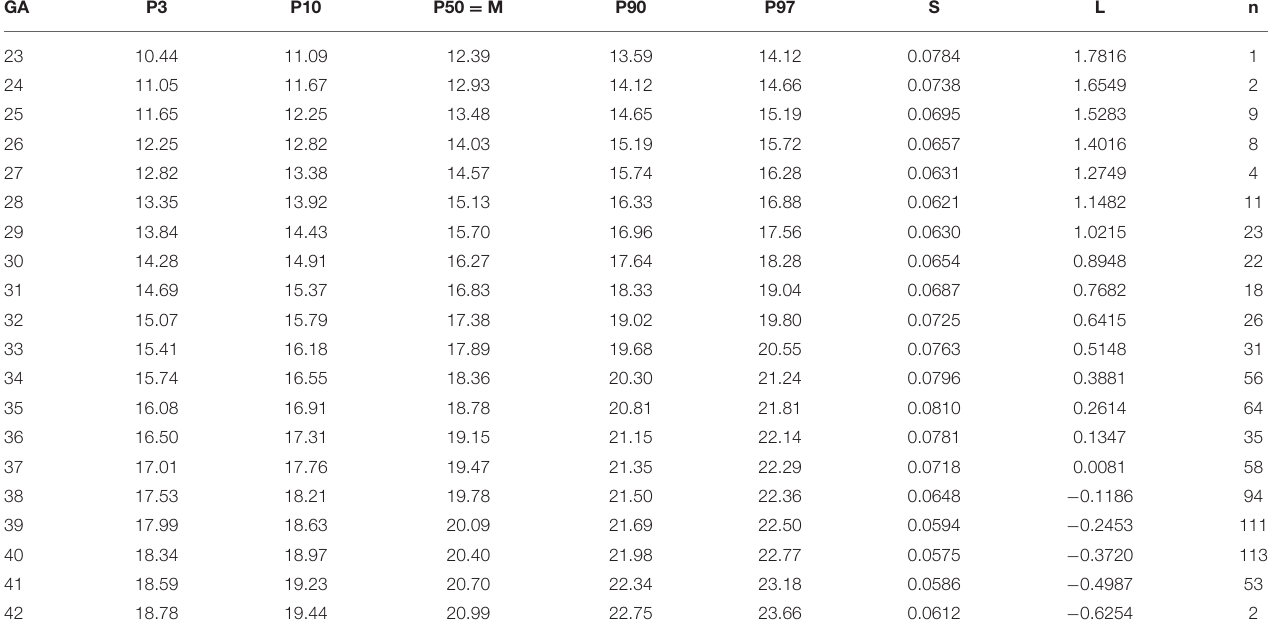
TABLE 3 | LMS parameters of models of transvertical EED (vEED) for girls.